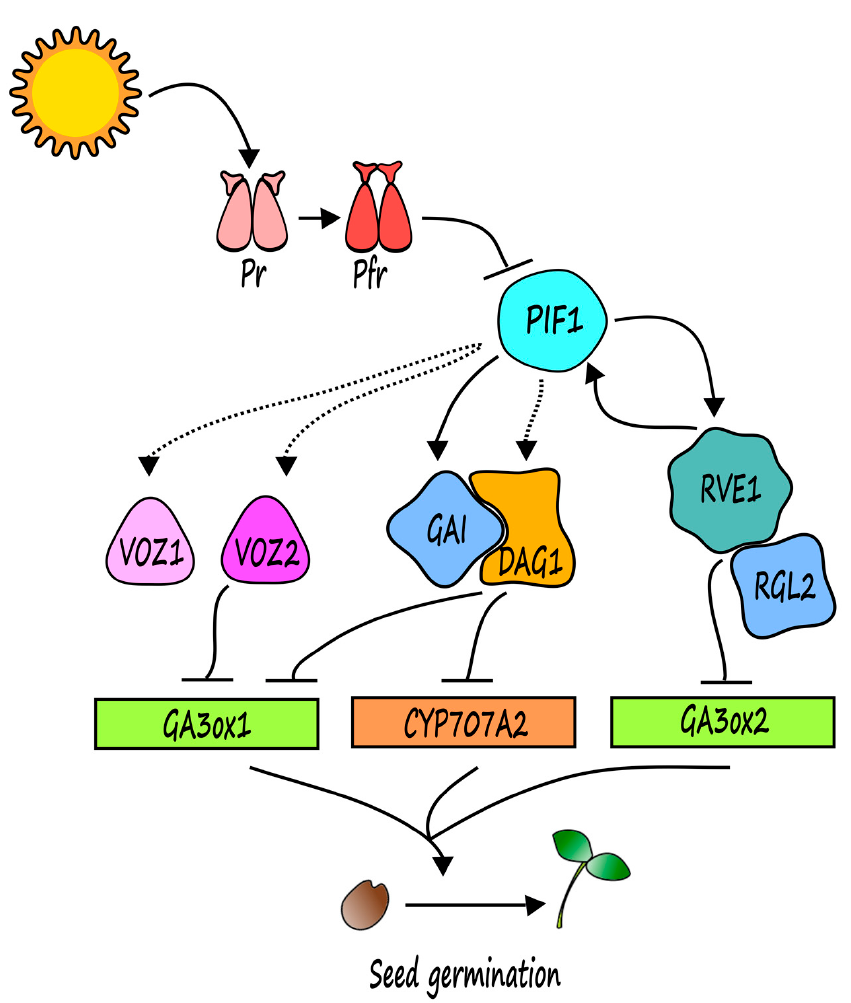
Figure 1. An integrated model of the molecular pathway underlying light-mediated seed germination. Updated model of the phyB-PIF1 signaling pathway regulating the seed germination process. PIF1 di- rectly activates GAI and RVE1 expression, and in turn RVE1 directly induces PIF1 . RVE1 interacts with the DELLA protein RGL2 to repress GA3ox2 , while GAI interacts with DAG1 to repress GA3ox1. The transcription factors VOZ1 and VOZ2 also repress GA3ox1 , downstream PIF1. Dotted arrow, indirect control; full arrow, direct control; Pr, phyB inactive form. Pfr, phyB active